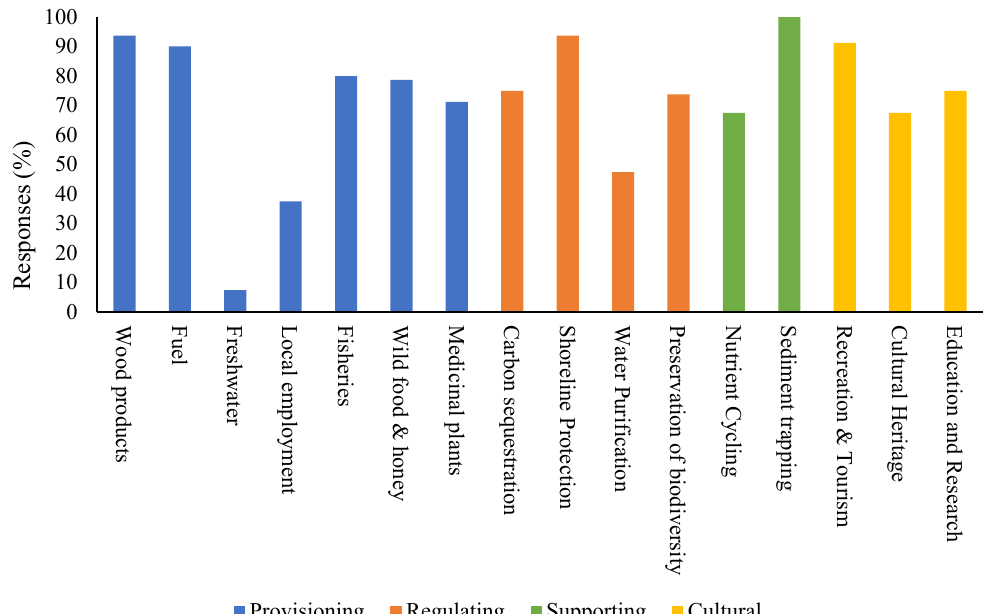
Figure 4. The responses of each ES were assessed from the survey administered to mangrove experts between January and April 2021 in Ungwana bay, Kenya.